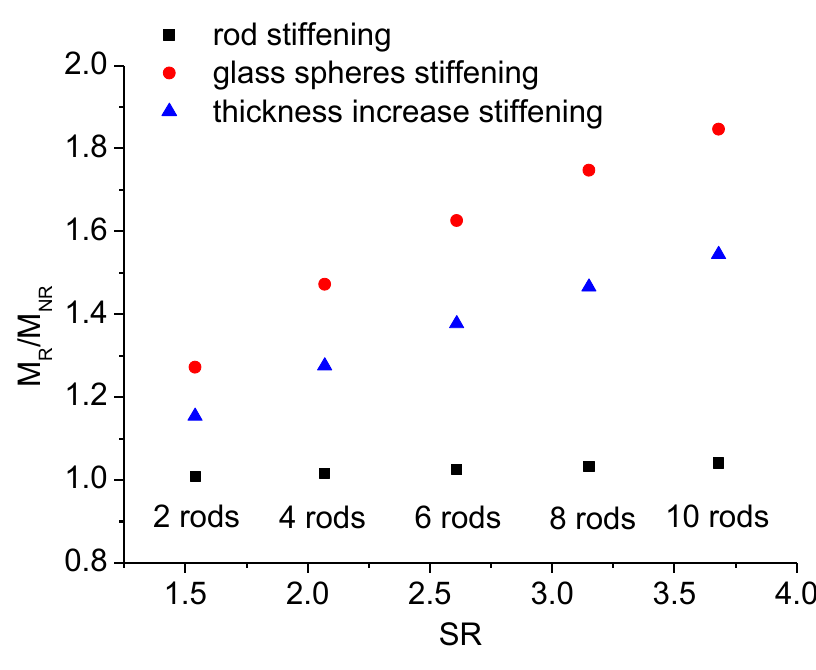
Figure 13. Creep curves for plastic lumber